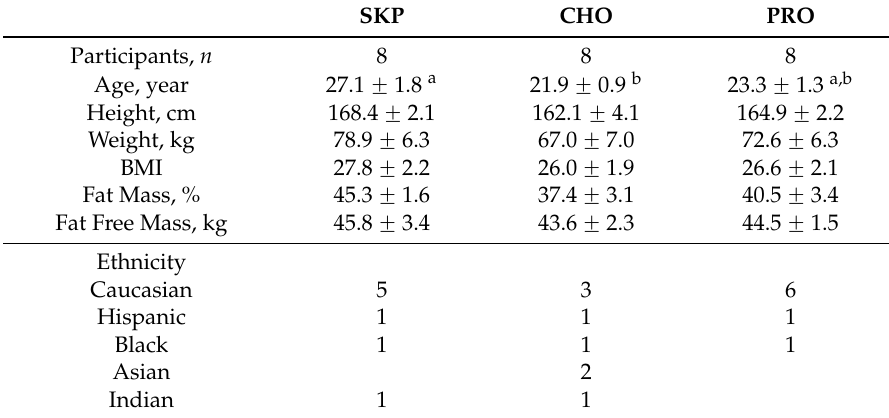
Table 2. Participant characteristics 1